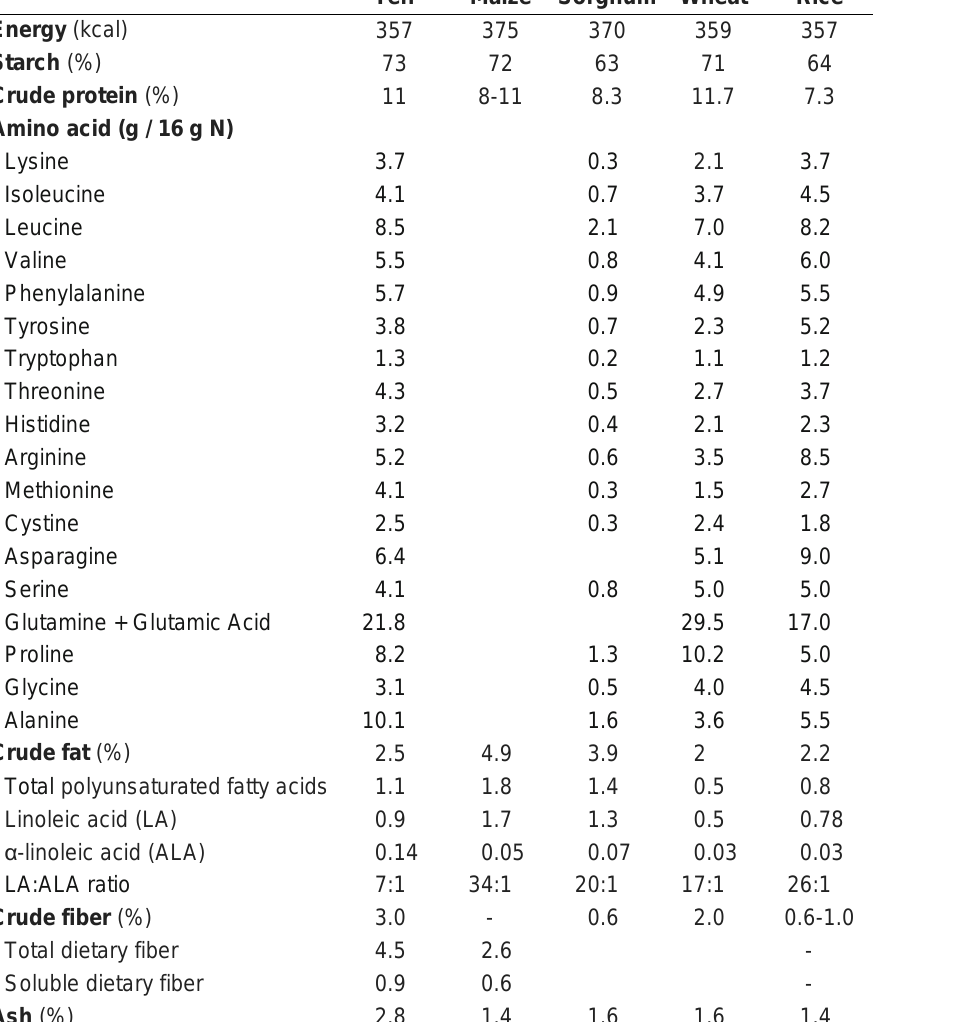
Table 3.1 — Macro, amino acid and fatty acid composition of teff grain compared to maize, sorghum, wheat and rice Teff